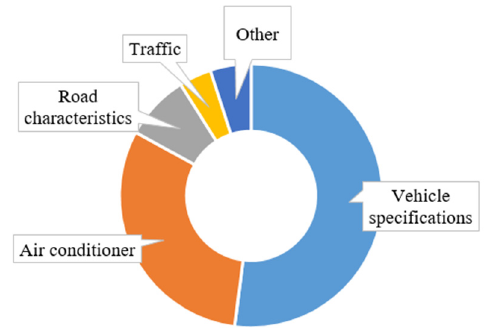
Figure 2. Factors contribution into the energy consumption [17–20].